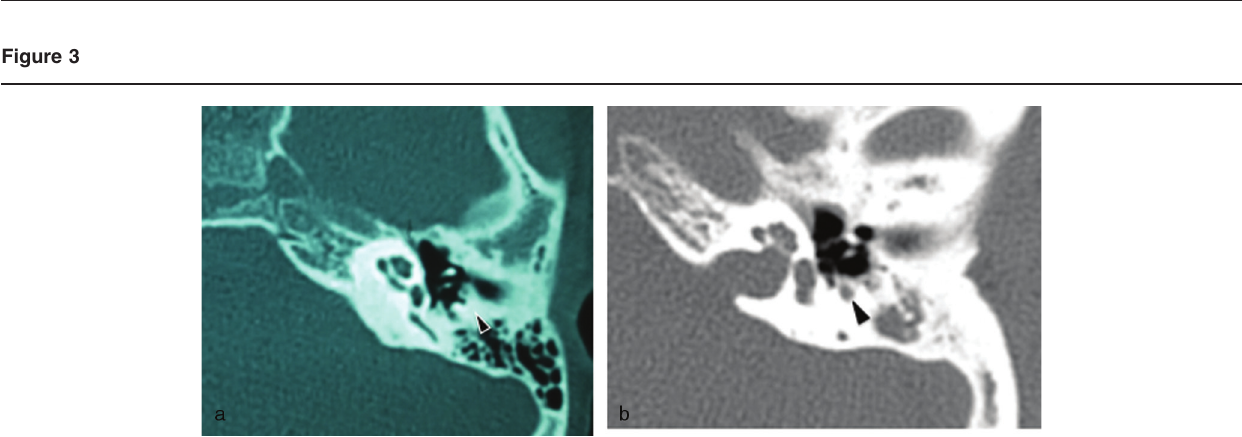
Table 2 Anatomical classification between otitis media with effusion and normal temporal bone scans as regards facial nerve protrusion, new bone formation around the canal, and cellularity of facial recess Diseases OME Normal Type 1* 21 101 Type 2 8 15 Type 3* 4 4 OME, otitis media with effusion. * P < 0.005.